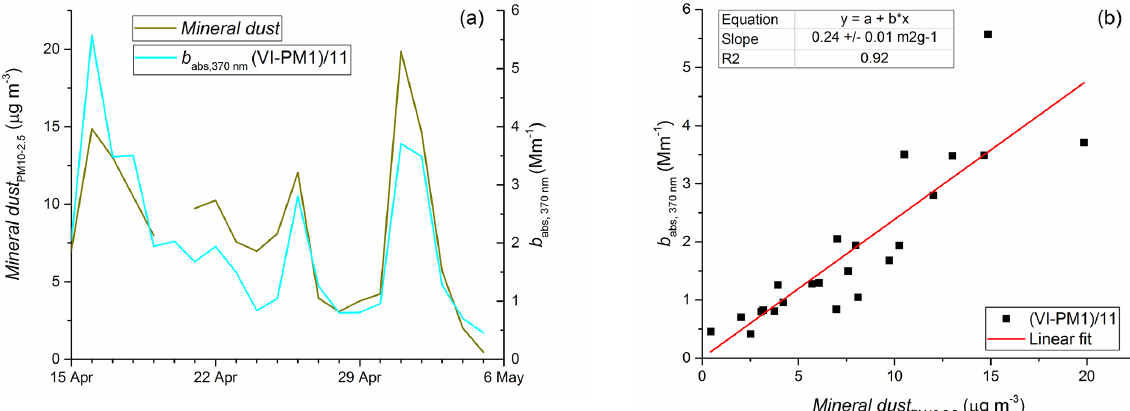
Figure 7. The time series (a) and the correlation (b) between the absorption coefficient of coarse particles obtained using the VI-PM1 method versus mineral dust concentration in the coarse fraction.